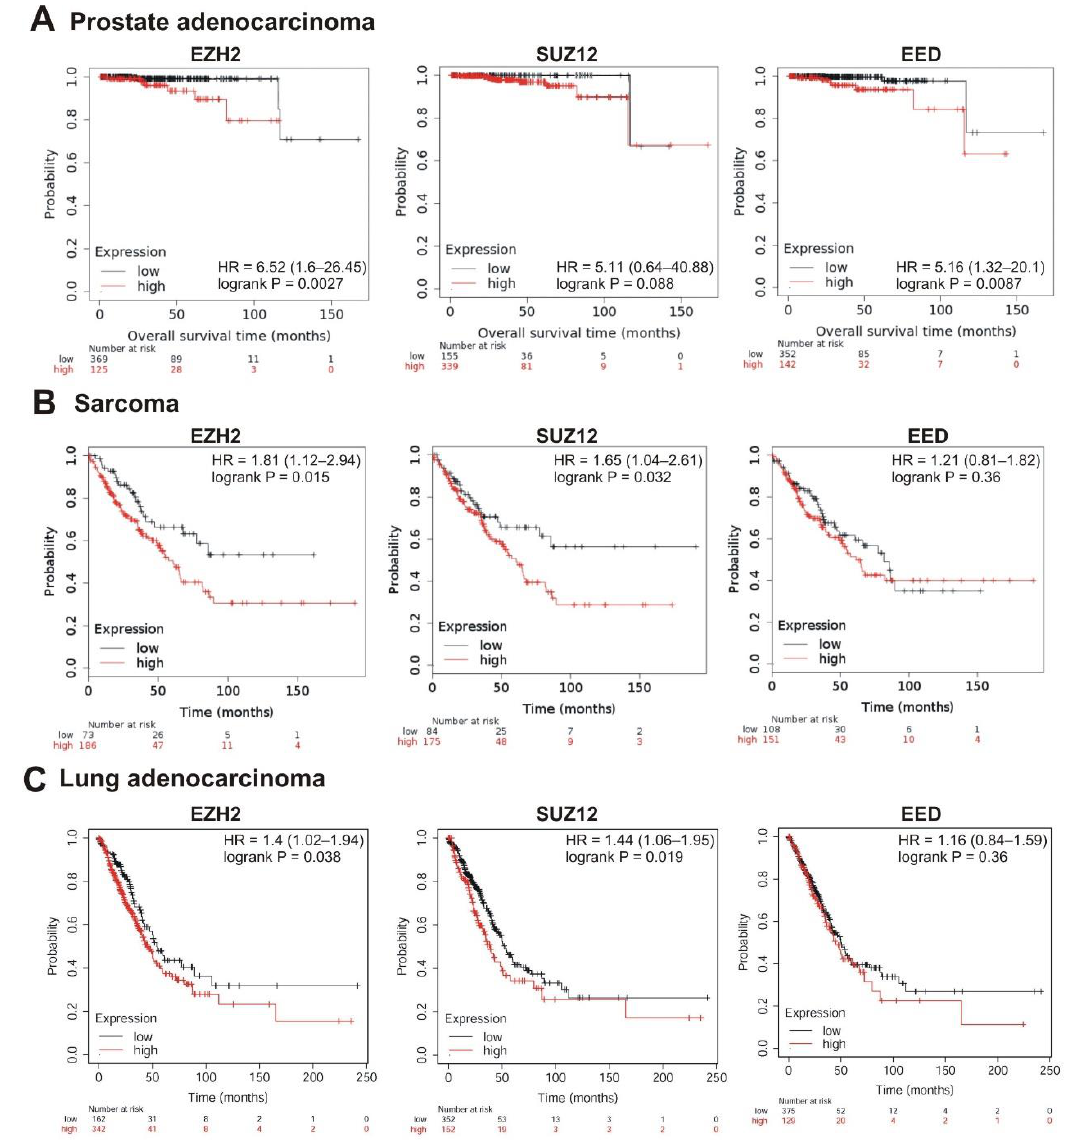
Figure 5. Correlation between the overall survival and the levels of EZH2 , SUZ12 or EED gene expression. ( A ) Prostate adenocarcinoma, ( B ) sarcoma, and ( C ) lung adenocarcinoma. The analysis was performed using KMplot resource.